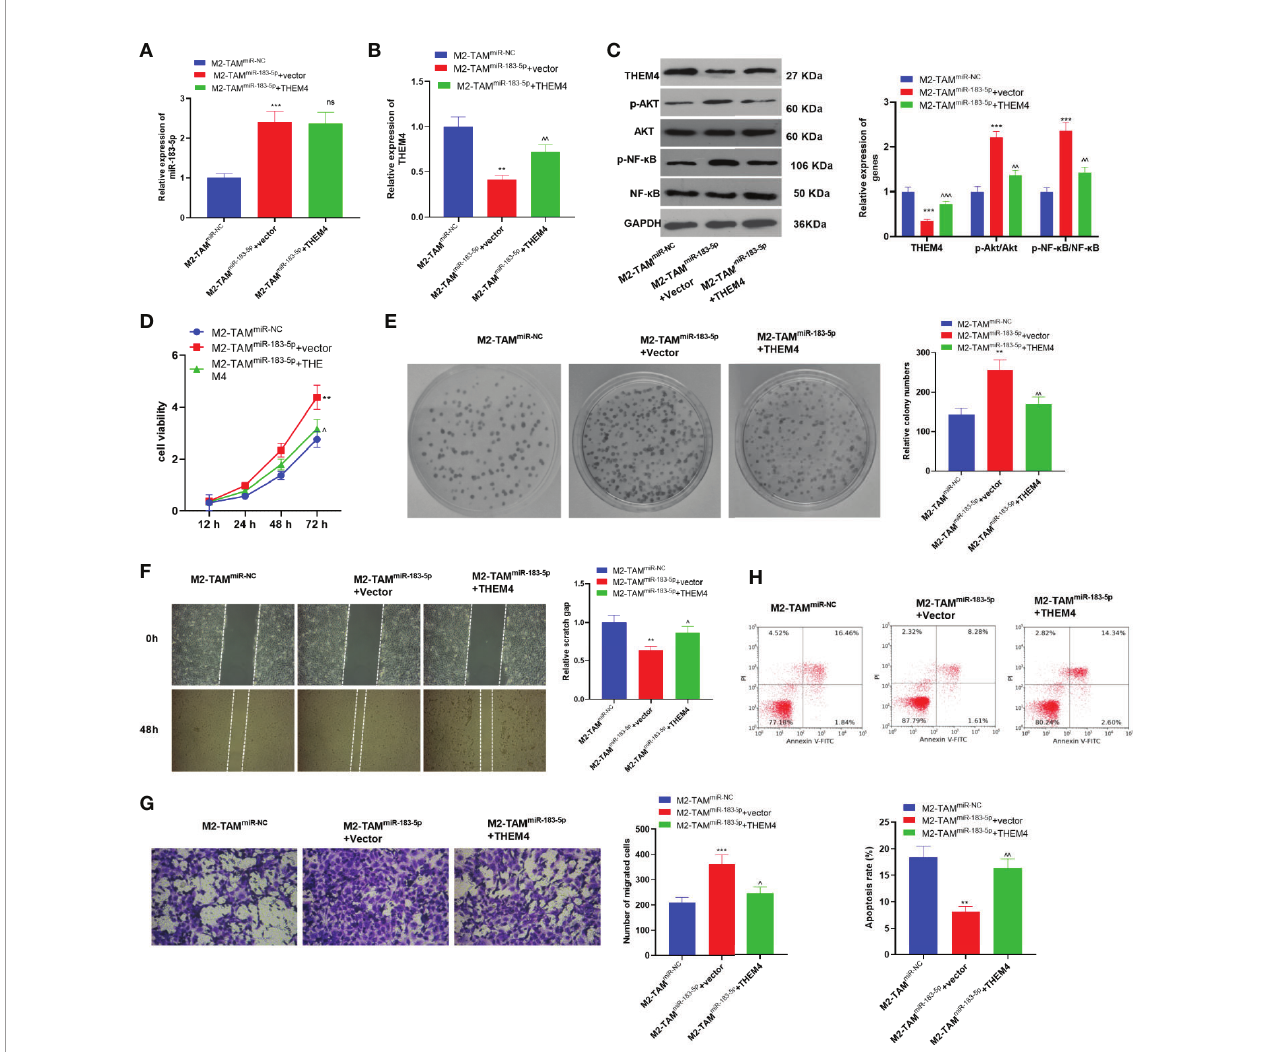
FIGURE 7 | Overexpressing THEM4 abated the M2-TAM miR-183-5p exosomes induced malignant progression of CC cells. The THEM4 overexpression model was constructed in SW480 cells, which were then deal with exosomes from M2-TAM miR-NC or M2-TAM miR-183-5p . (A, B) The miR-183-5p and THEM mRNA pro fi les in SW480 cells were monitored by qRT-PCR. (C) The THEM4, AKT, NF- k B levels in SW480 cells were detected by WB. (D) CCK-8 assay was employed to examine CC cell proliferation. (E) Colony formation assay was applied to detect the ability of cells to form colonies. (F) Wound healing test determined cell migration. (G) Cell invasion was monitored by Transwell assay. (H) Apoptosis was determined by FCM. ** P < 0.01, *** P < 0.001 ( vs . The M2-TAM miR-NC group), ns, P > 0.05, ^ P < 0.05, ^^ P < 0.01, ^^^ P < 0.001 ( vs . The M2-TAM miR-183-5p +Vector group).